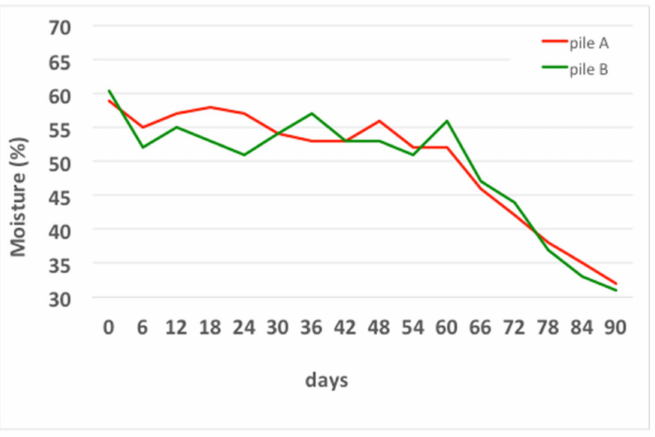
Figure 7. Moisture temporal variation in the compost